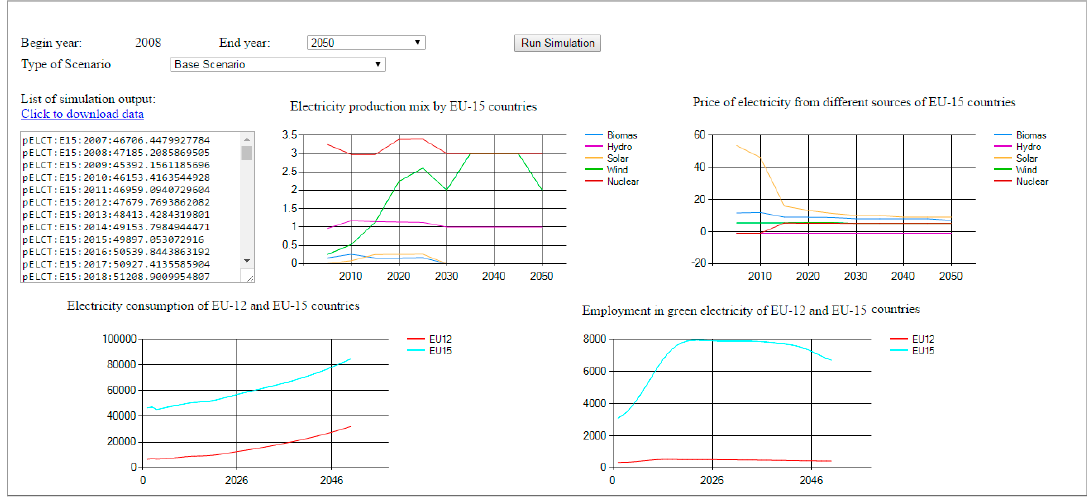
Figure 6. An example of web-based user interface of the integrated system.